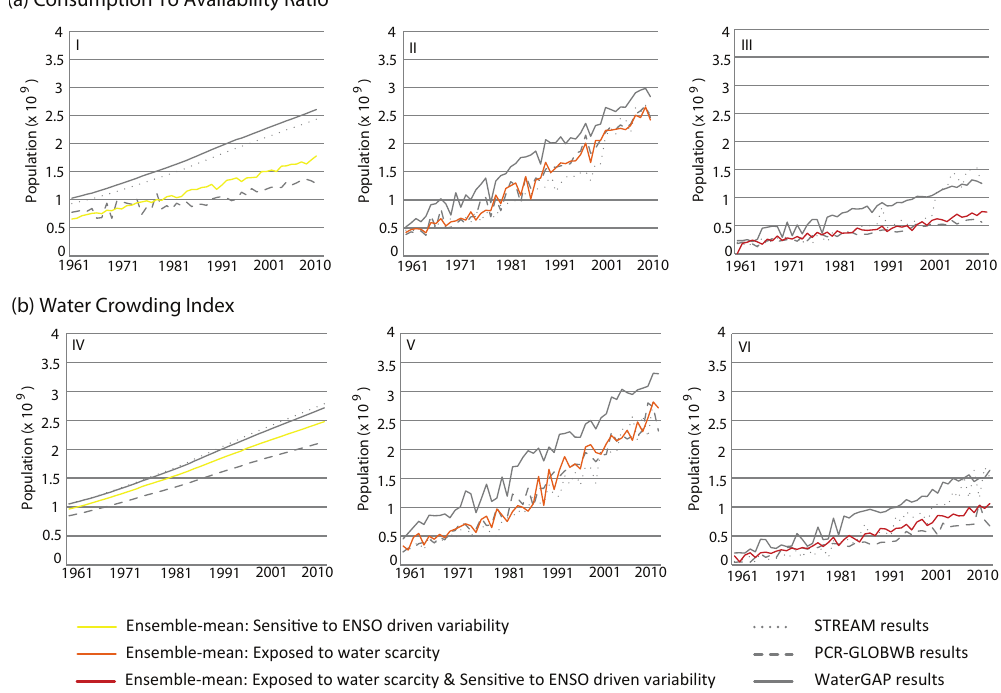
Figure 7. Development of the population exposed to water scarcity events (CTA ratio) and/or being sensitive to ENSO-driven climate variability over the period 1961–2010, as assessed by the individual global hydrological models (STREAM, PCR-GLOBWB, and WaterGAP) and the ensemble mean. (I) and (IV) show the development in population sensitive to ENSO-driven climate variability as estimated under the ensemble-mean (yellow) and individual GHMs (grey). (II) and (V) present the increase in population exposed to water scarcity events for the ensemble-mean (orange) and individuals GHMs (grey). (III) and (VI) visualize the amount of people being exposed to water scarcity events, while at the same time living in areas with a significant correlation to ENSO-driven climate variability for the ensemble-mean (red) and individual GHMs